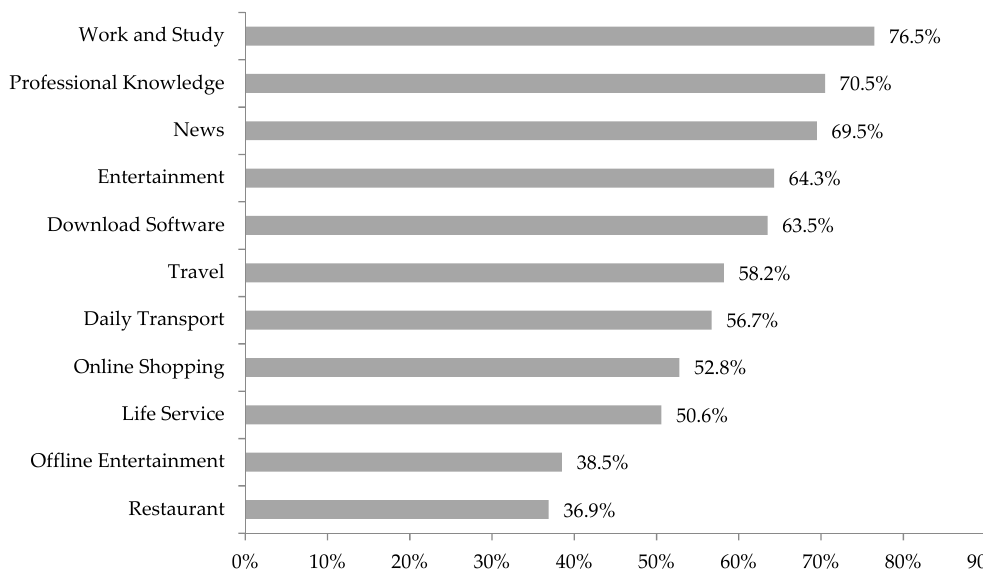
Figure 1. Search Engine Usage under Different Scenarios in China.